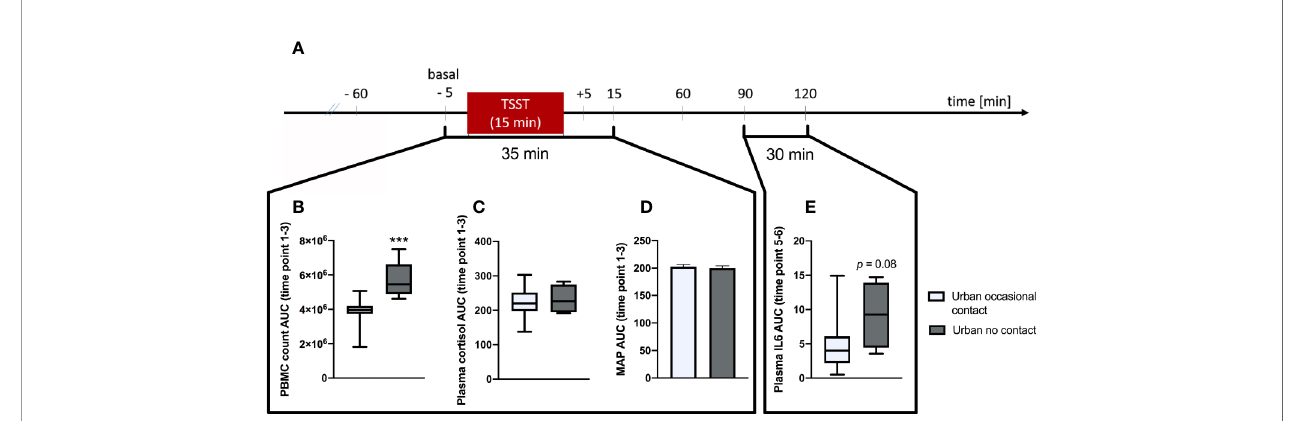
FIGURE 3 | Analysis of Trier Social Stress Test (TSST)-induced alterations on immunological and physiological parameters between urban participants growing up with no animal contact at all vs. urban participants growing up with “ occasional ” animal contact until the 15 th birthday, respectively. (A) Timeline of the experimental procedure. At – 60 min time point, the venous catheter as well as the blood pressure and heart rate monitor were placed. Before ( – 5 min) and after (5, 15, 60, 90, and 120 min) the TSST, different immunological and physiological parameters where assessed. (B) Area under the curve with respect to ground (AUC) analysis indicates that urban participants growing up with no animal contact at all ( n = 5) vs. urban subjects growing up with “ occasional ” animal contact until the 15 th birthday ( n = 15), respectively showed signi fi cantly higher counts of plasma peripheral blood mononuclear cells (PBMCs) between time point 1 and 3. This effect was also by trend visible in plasma interleukin (IL)-6 levels between time point 5 and 6 (E) . There were no signi fi cant differences between both groups in the AUC between time point 1 and 3 of plasma cortisol levels (C) and the mean arterial pressure (MAP; D ), respectively. Normally distributed data are presented as bars (mean + SEM). Non-normally distributed data are presented as box plots (Median, min, max, 25 th and 75 th percentile) *** p <